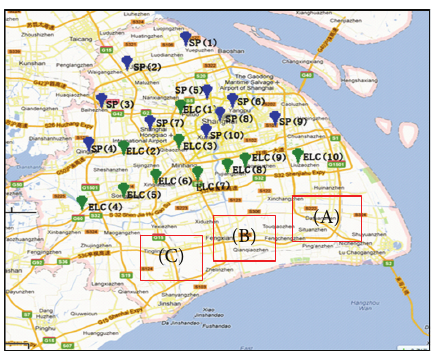
Figure 4: The location of facilities in an ESC